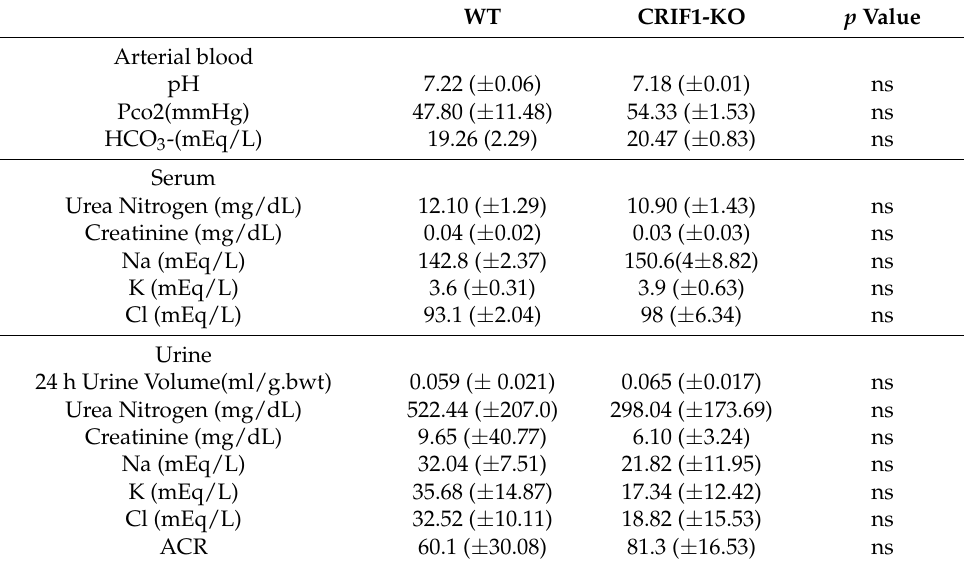
Table 1. Baseline parameters in wild-type and CR6-interacting factor-1 knockout mice.